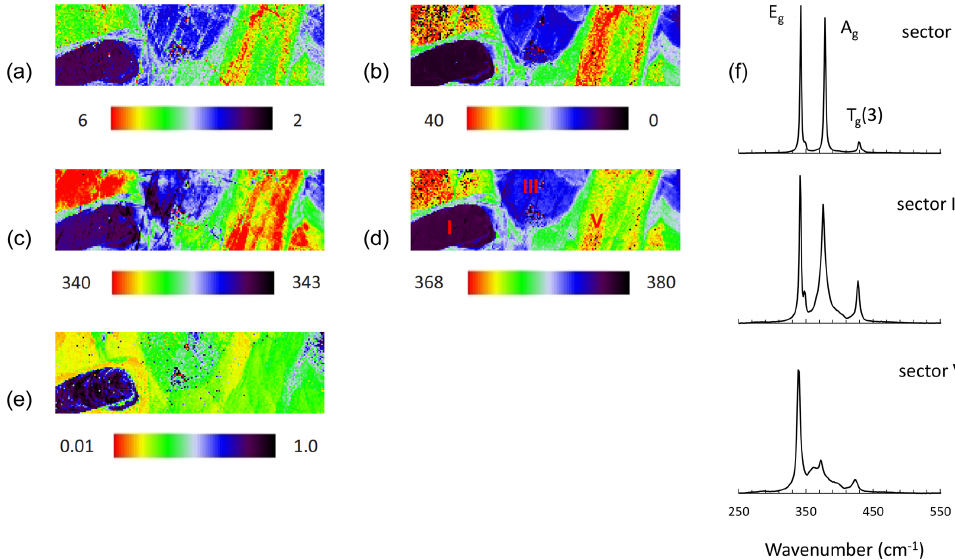
Figure 9. Raman map of pyrite grain with 633nm laser after BIB polishing. FWHM of E g (a) and A g (b) modes (presented in cm − 1 ), Raman shift of E g (c) and A g (d) modes (presented incm − 1 ), intensity ratio of E g and A g (A g / E g ) modes (e) , and Raman spectra of pyrite collected from sectors I, III, and V by point measurements (f) .